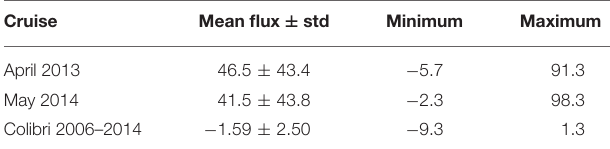
TABLE 3 | Mean CO 2 flux with its standard deviation (std), minimum, and maximum values (in mmol m − 2 d − 1 ) on the Amazon continental shelf and on the French Guiana continental shelf (30 Colibri